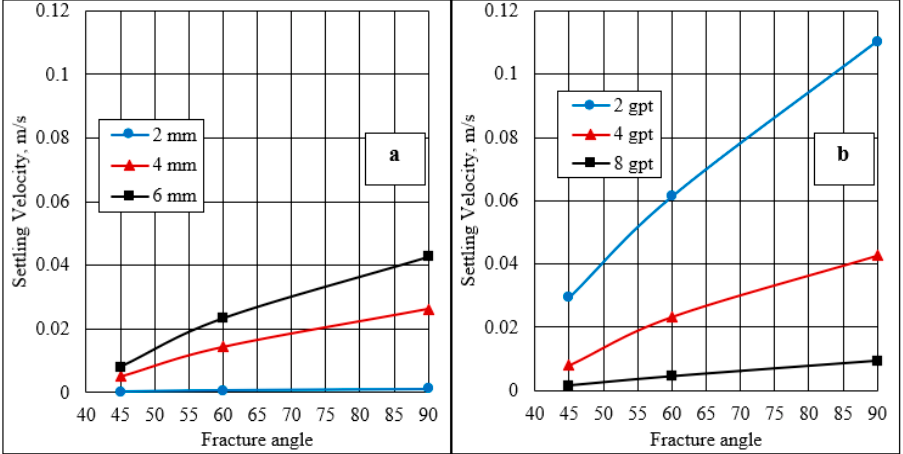
Figure 18. Effect of the fracture angulation on the settling velocity using ( a ) 4 gpt concentration, and ( b ) 6 mm particle size.